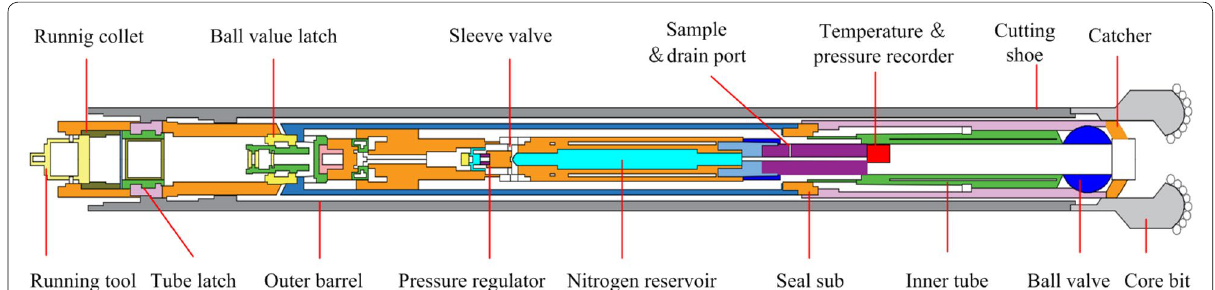
Figure 13 Schematic of the pressure temperature coring system (PTCS)